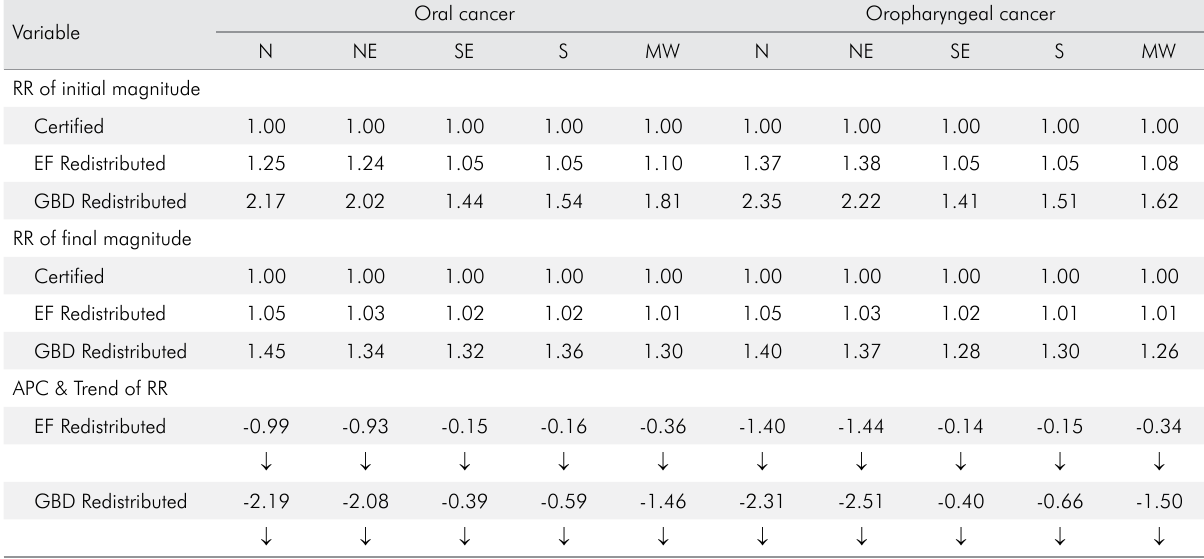
Table 3. Certified versus redistributed mortality for oral and oropharyngeal cancer by the EF and GBD methods by macroregion, for 100,000 inhabitants: Rate Ratio (RR) of the final and initial magnitudes (redistributed/certified), annual percent change (APC), and trend of RR. Brazil,